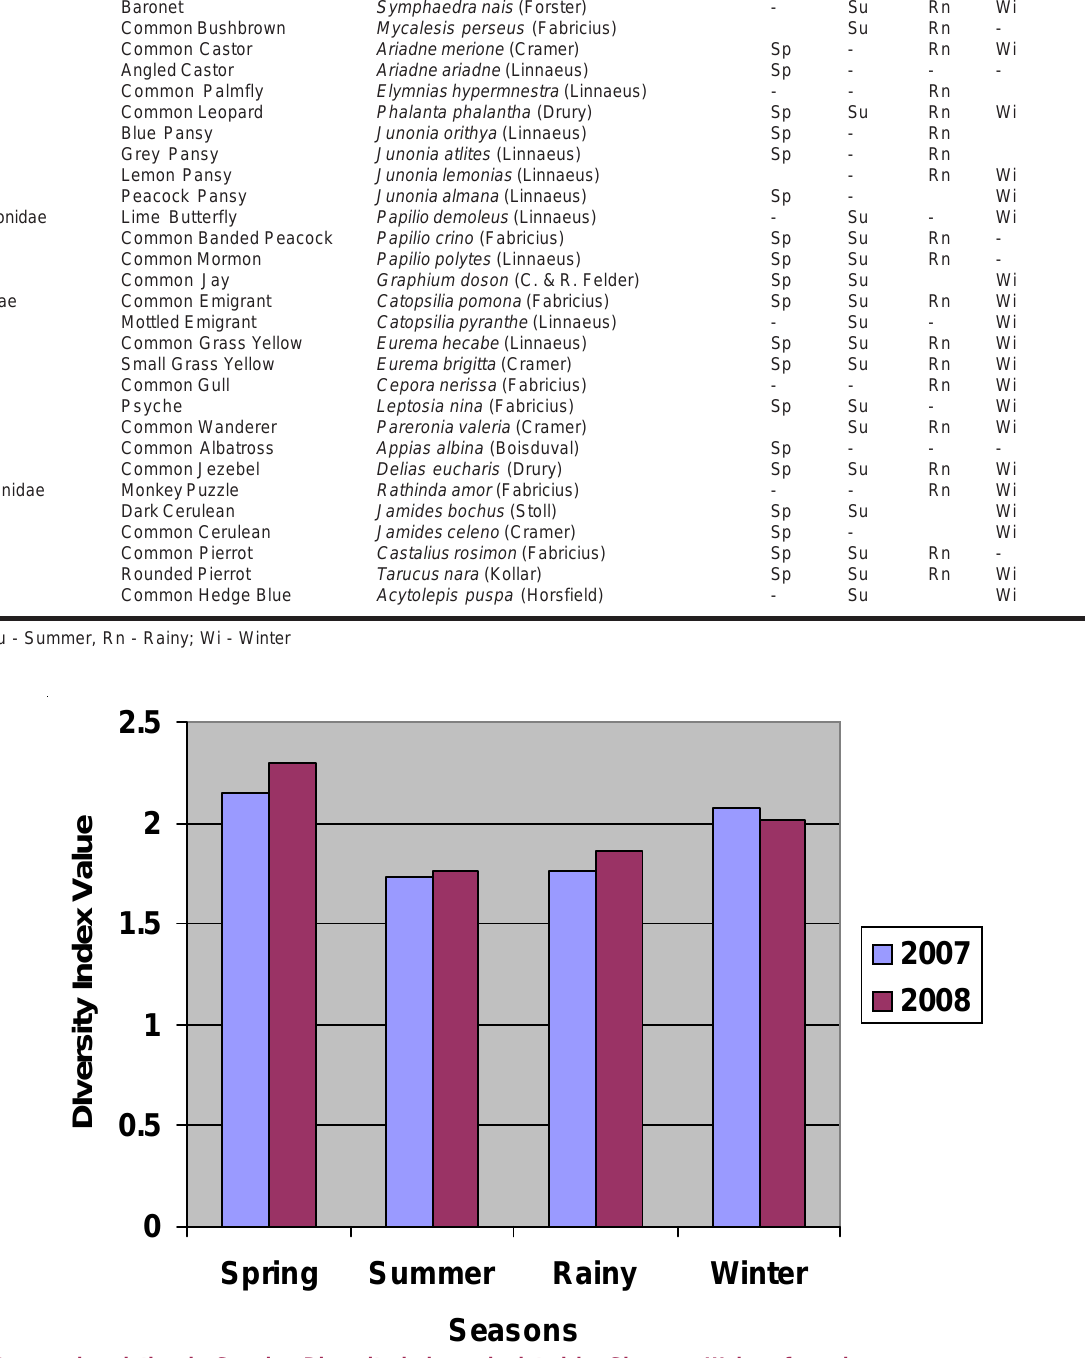
Figure 1. Seasonal variation in Species Diversity index calculated by Shannon-Weiner